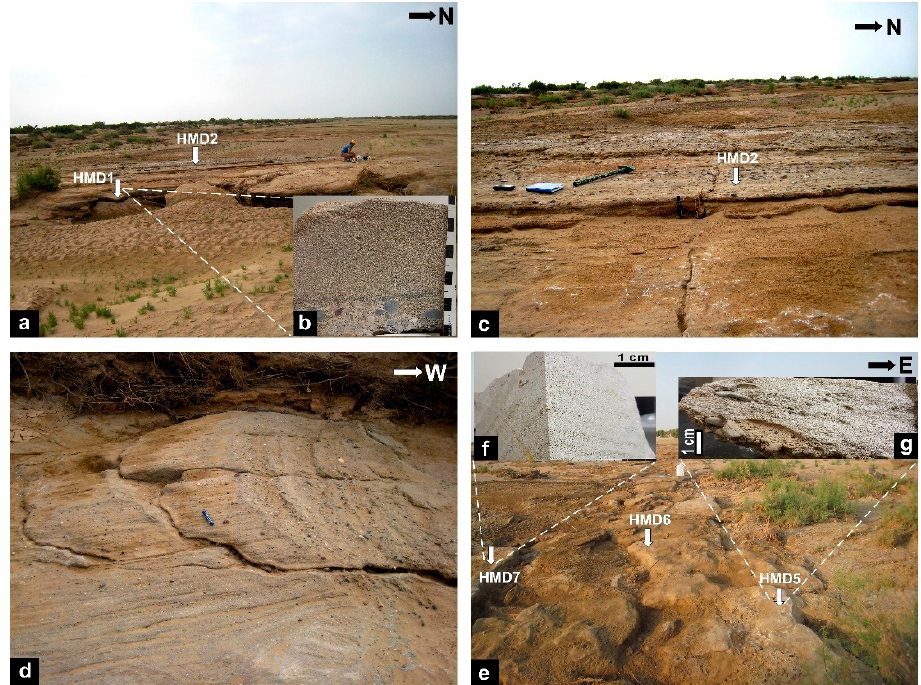
Figure 3. Field Photographs showing the characteristic features and locations of the samples of the beachrock at the mouth of Wadi Al-Hamd. ( a – c ) The near horizontal to gently westward inclined gravel-rich proximal strata. ( b ) Close-up view of sample HMD1, showing normal grading from well-rounded gravel to massive sands. ( d ) Westward gently inclined graded bedded strata. ( e ) Fracture system in the distal beds. ( f , g ) Close-up view showing internal features of the poorly-sorted gravelly sand (HMD5) and the low angle cross bedded with foresets displaying normal grading in sample HMD 7.